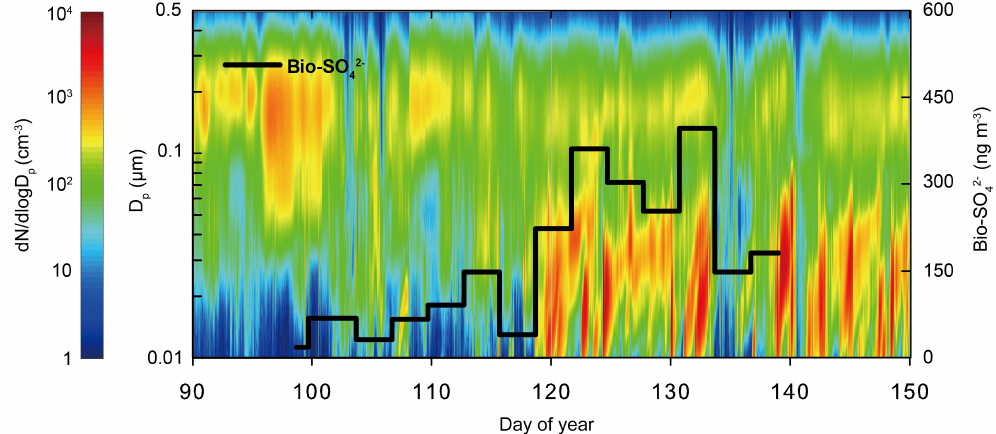
Figure 7. Spectral plot of number size distribution (d N/ dlog D p ) as a function of particle diameter ( D p , 10–500nm) and day of year during April and May 2015. The black line represents the concentration of biogenic SO 2 −